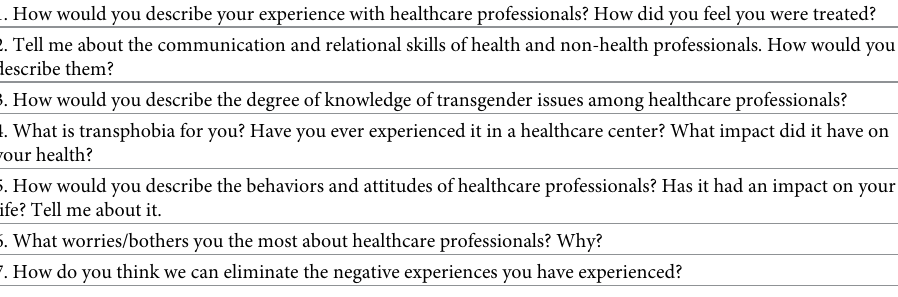
Table 1. Sample questions from the semi-structured